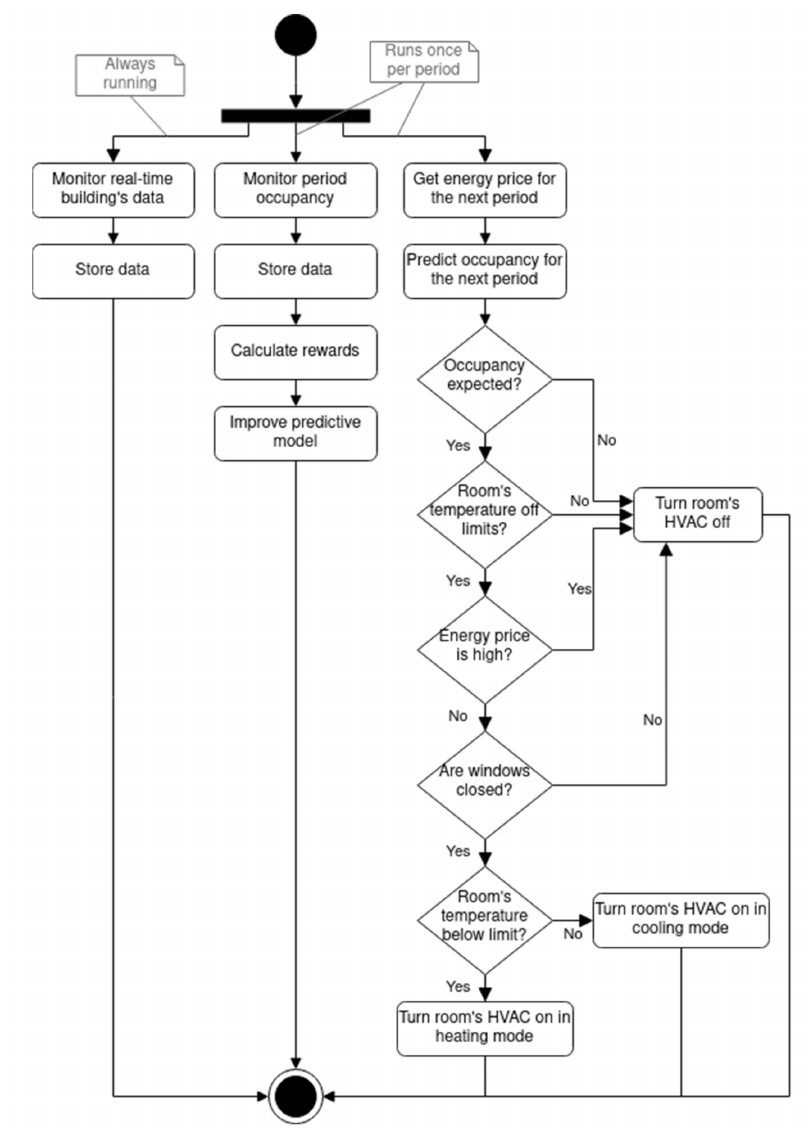
Figure 3. Solution